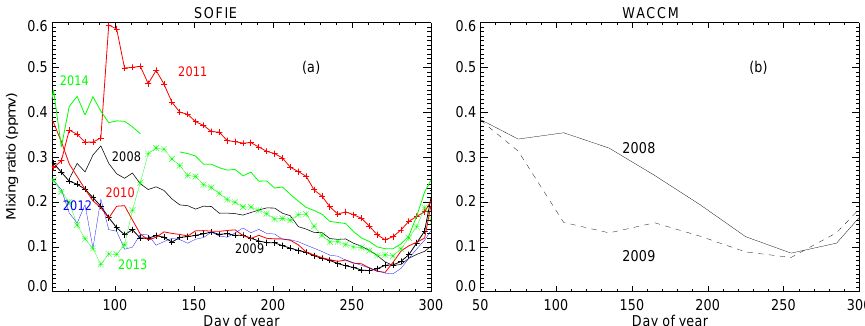
Figure 2. Comparison of time series of zonal mean CH 4 mixing ratio at 1.47hPa. (a) SOFIE data for the indicated years. The data have been grouped into 5-day bins. See Fig. 1 for a discussion of the latitudes. (b) WACCM for 2008 (solid) and 2009 (dashed) at a single fixed latitude of 75 ◦